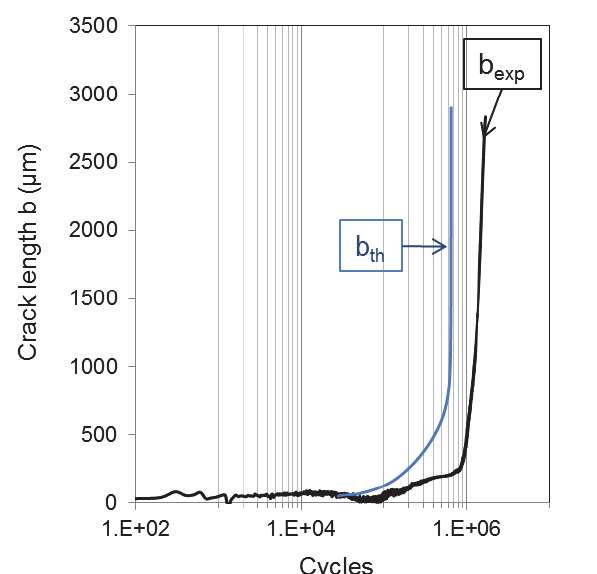
Figure 7: Comparison of experimental and theoretical crack propagation rates. (R=4.6mm, P, σ F,moy / σ y,flat =0.78, R F =0.85, Q*/P=0.30). Application of prediction method to a mixed load